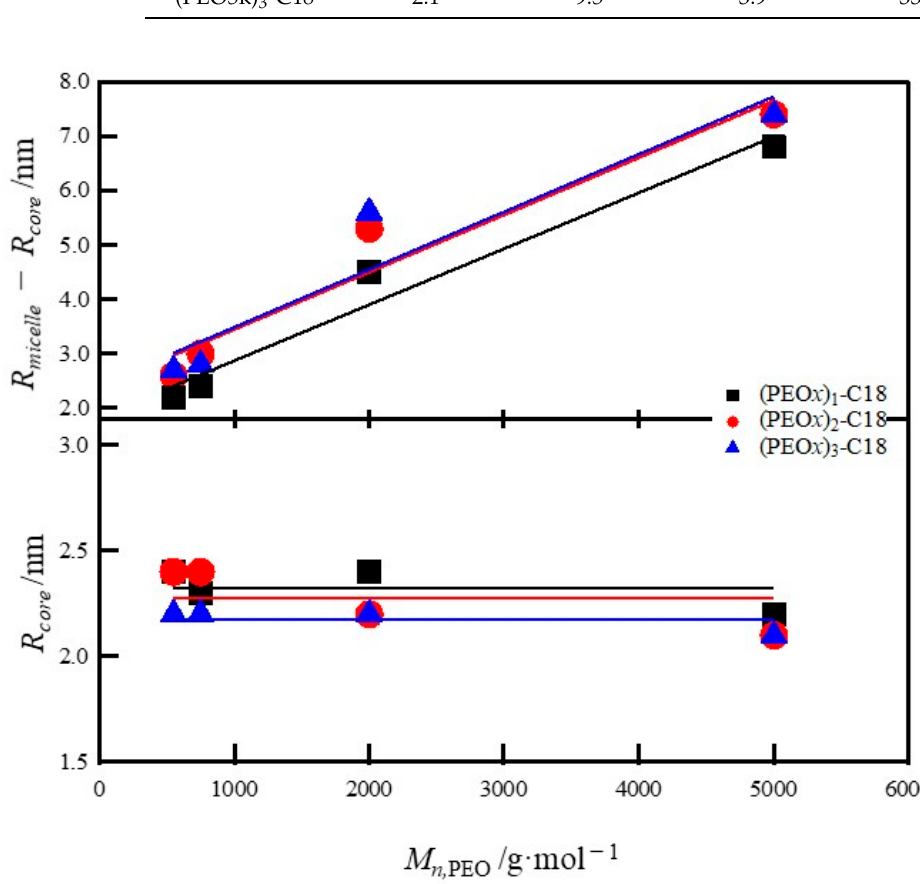
Figure 4. M n ,PEO dependence of R core s and thickness of corona of (PEO x ) y -C18 micelles.